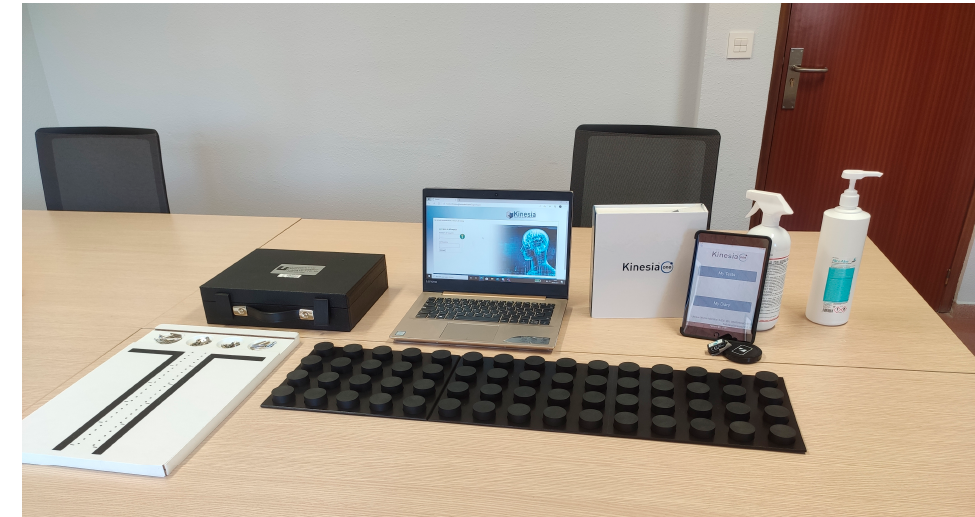
Figure 3. Evaluation kit (Purdue pegboard, Minnesota and Kinesia